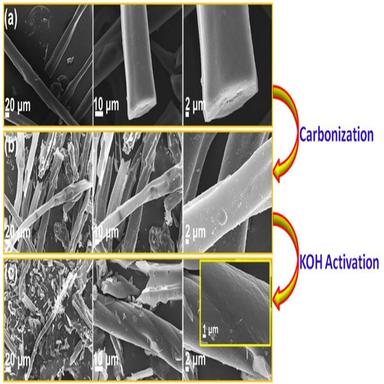
SEM images of (a) APF, (b) TC and (c) TPC samples at different processes.